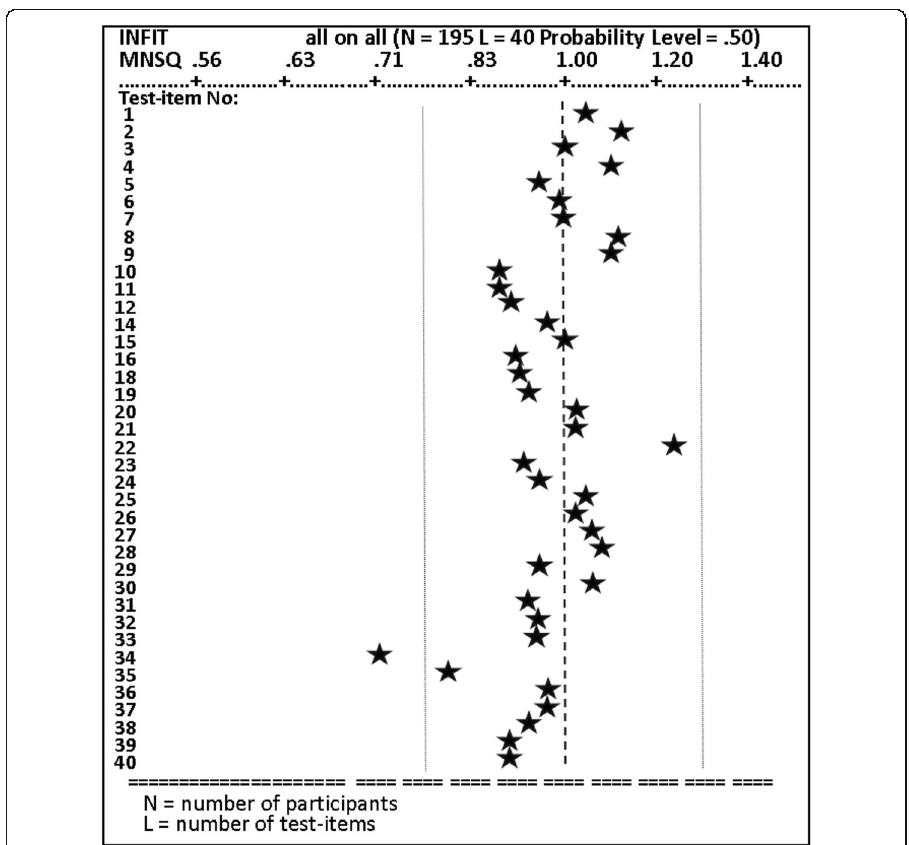
same line. The test-items that fall between the two vertical dotted lines (thresholds .77 to 1.30) are considered acceptable; test-items to the left overfit (see test-item 34), indicating duplication or having limited contribution. Underfit test-items to the right of the threshold lines, measure something else